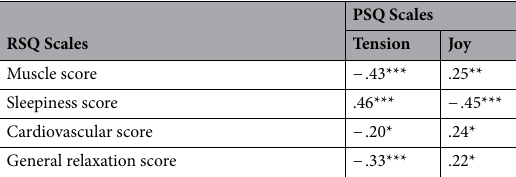
Table 6. Correlations between RSQ and PSQ scales. All correlations were tested one-tailed. * p < .05. ** p < .01. *** p < .001. All correlations remained significant after Bonferroni-Holm